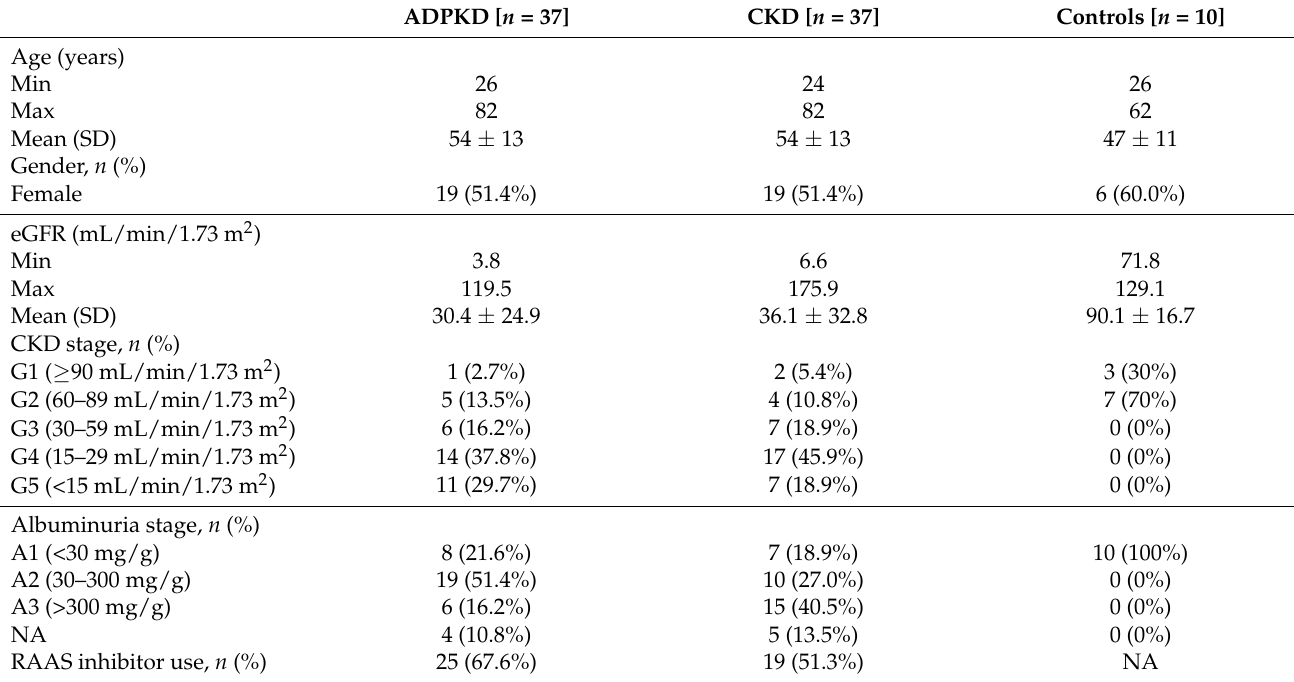
Table 1. Key clinical parameters are given for the three cohorts. None of the patients of the ADPKD cohort was treated with tolvaptan. CKD stages according to KDIGO. eGFR = estimated glomerular filtration rate; RAAS = renin angiotensin aldosterone system.